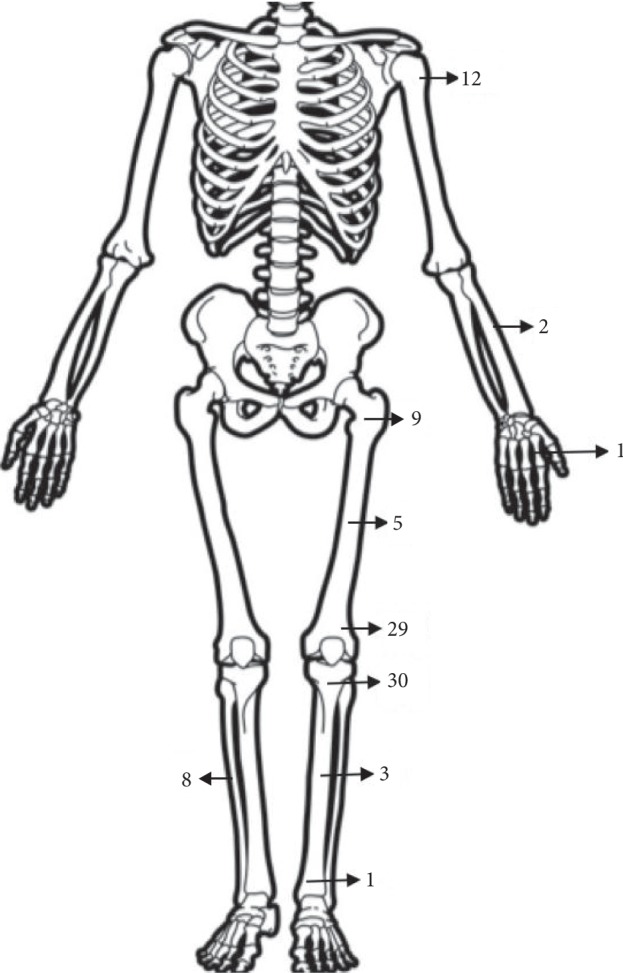
Distribution as per site.